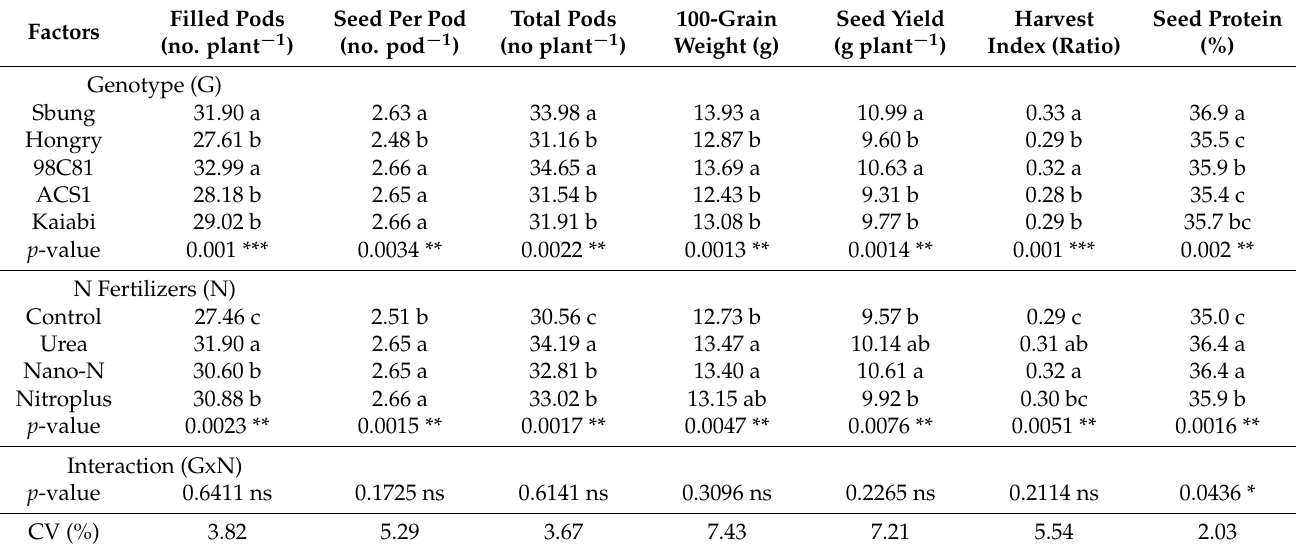
Table 4. Number of filled pods, total of pods, number of seed per pod, 100-grain weight, seed yield, harvest index, and seed protein, as affected by genotype and N fertilizer sources.